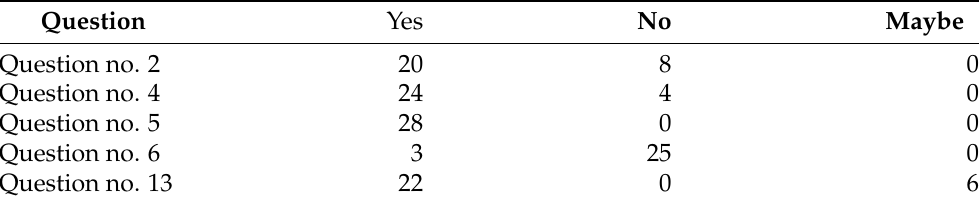
Table 11. Answers to the YES/NO questions of the questionnaire.